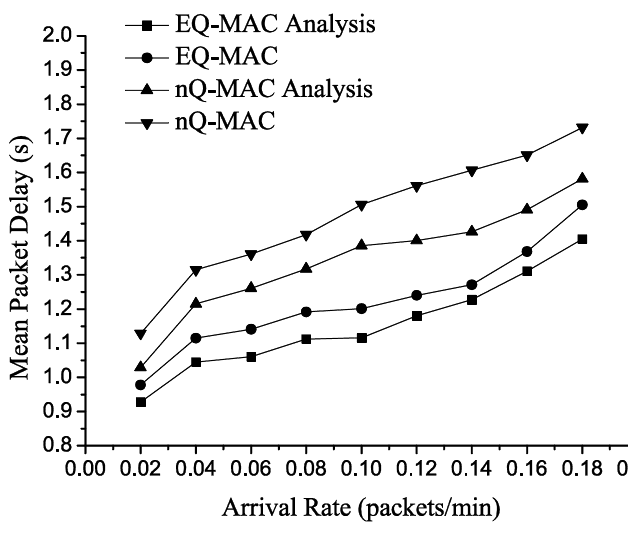
Figure 6. Mean Packet Delay vs . Arrival Rate.